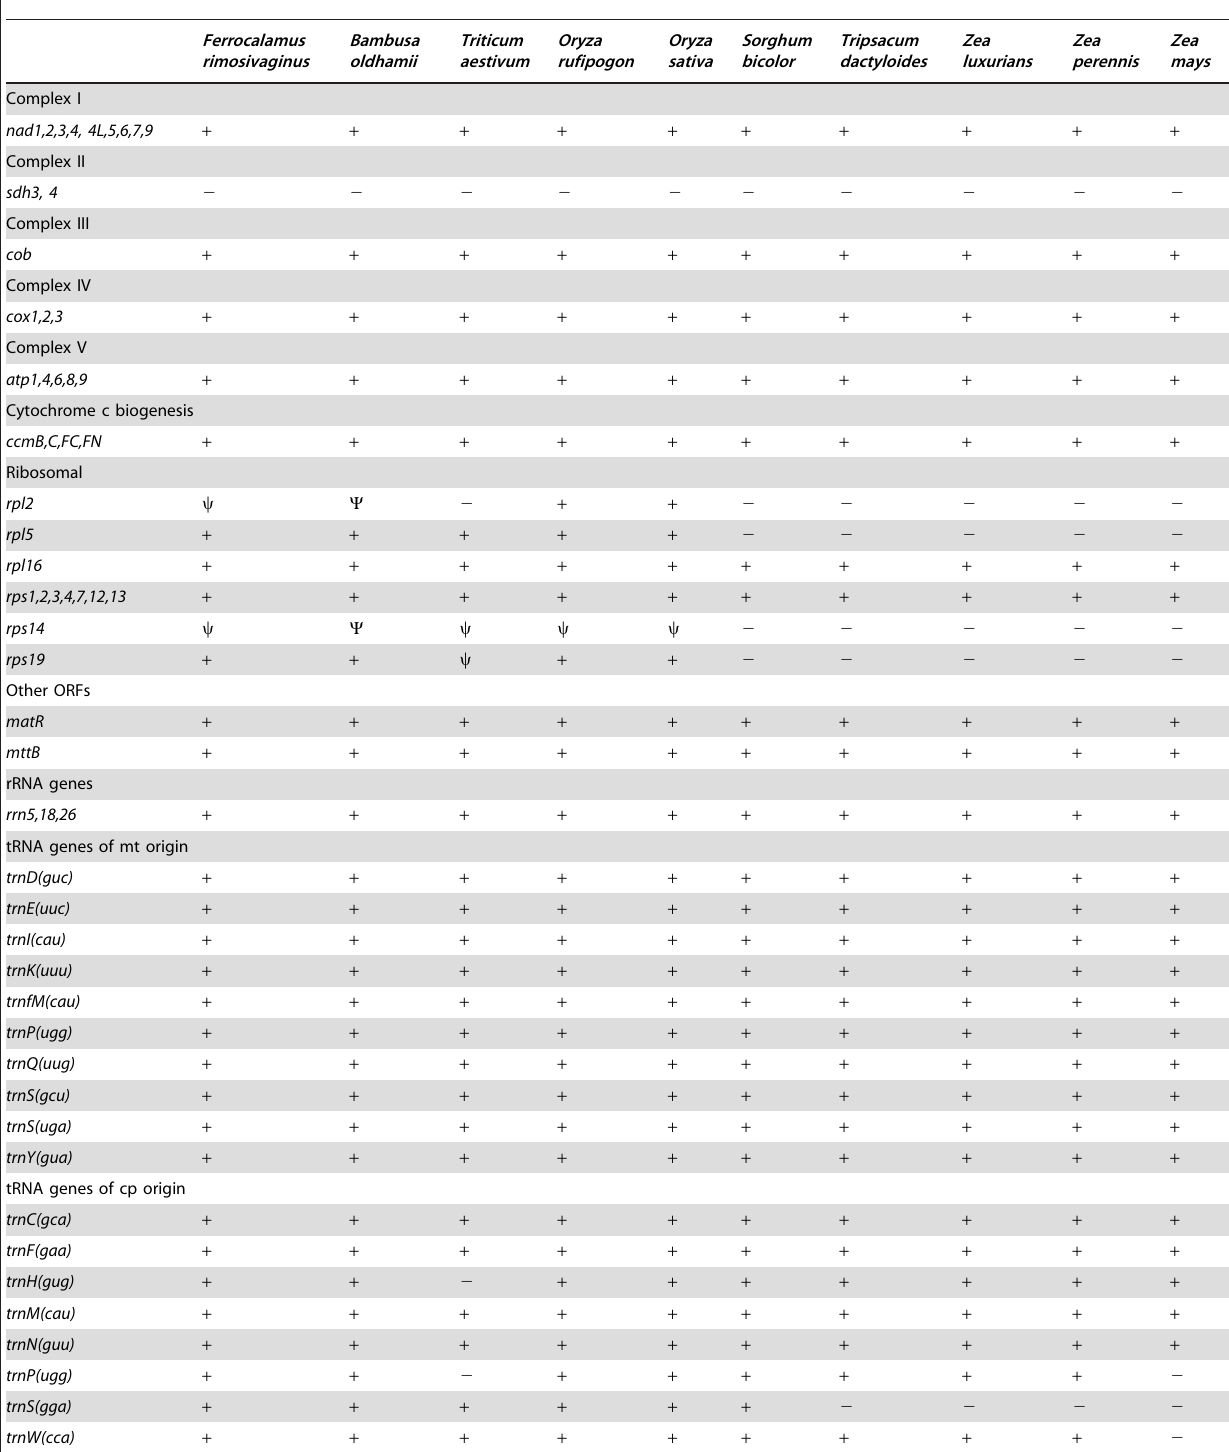
Table 4. Comparison of gene content among grass mitochondrial